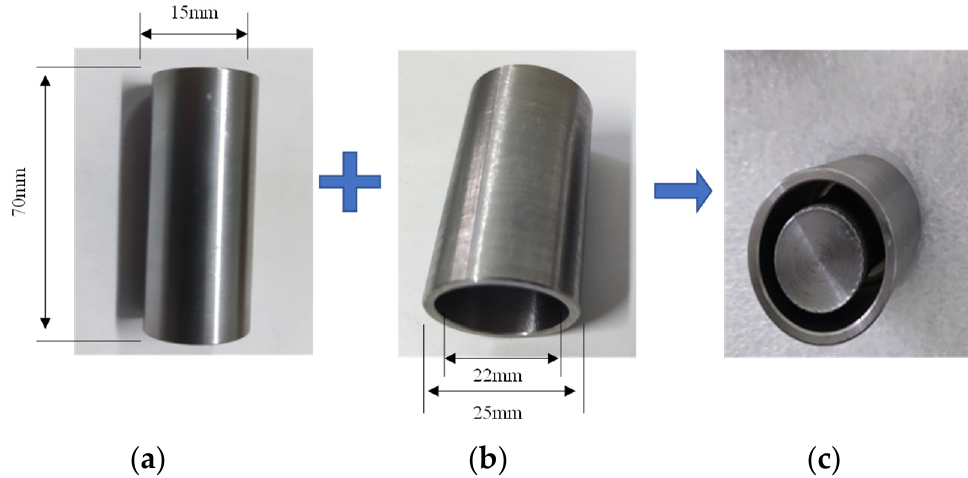
Figure 5. Assembly and dimensions of the model. ( a ) Solid cylinder. ( b ) Hollow casing. ( c ) Annular model.